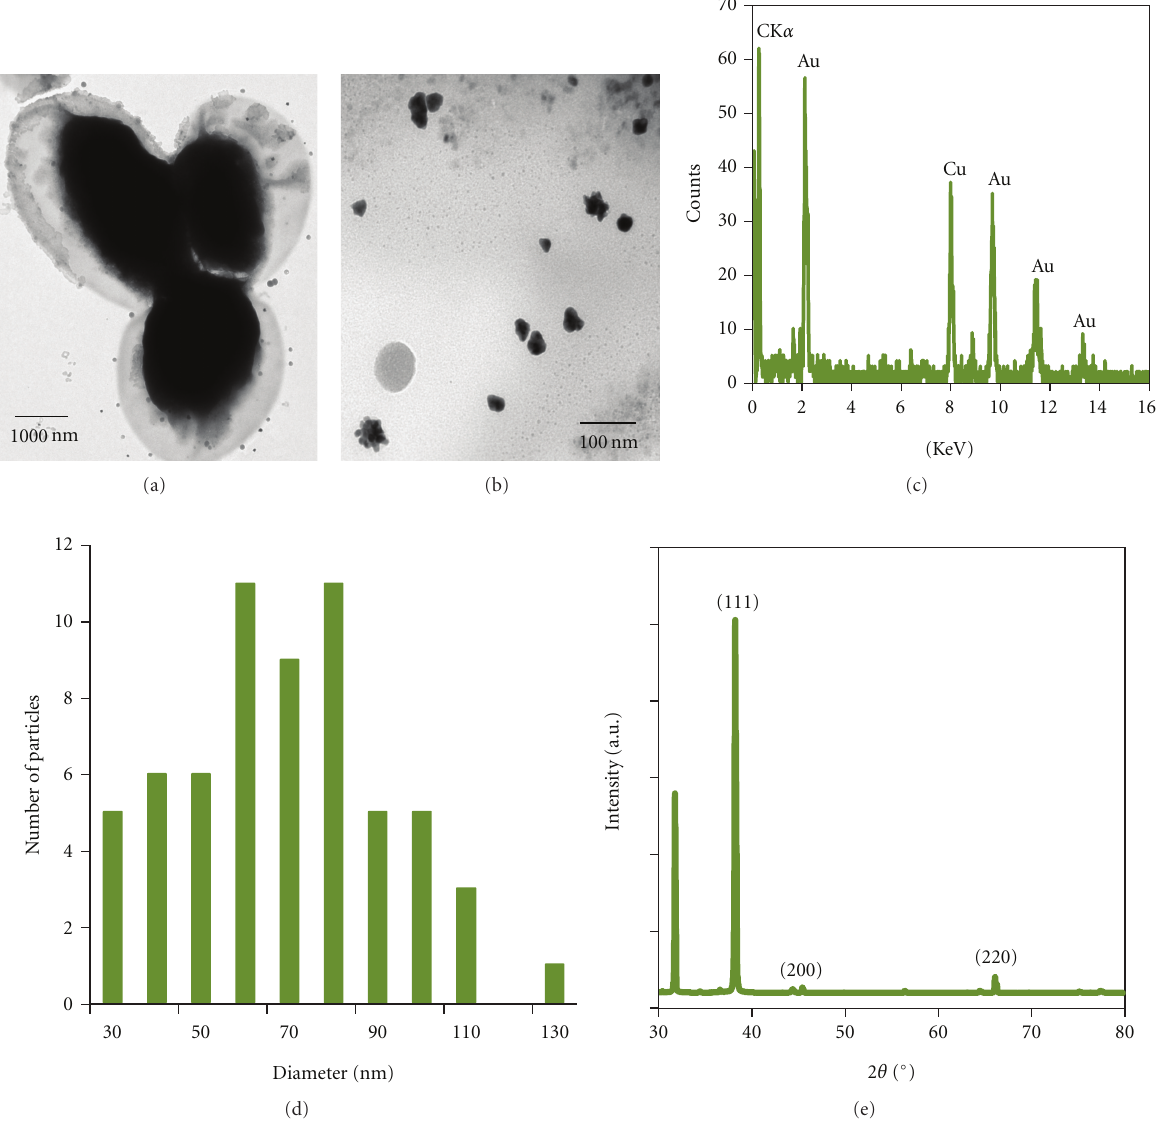
Figure 4: TEM micrographs recorded on a drop-coated film with yeast biomass/AuNPs aqueous suspension, after 24 h (a and b). EDX spectra (c) and particle size distribution histogram determined from the TEM micrographs (d). XRD pattern recorded from the thin film prepared by drop coating the biomass/AuNPs aqueous suspension after 24h on a Si wafer; the principal Bragg reflections are identified (e).